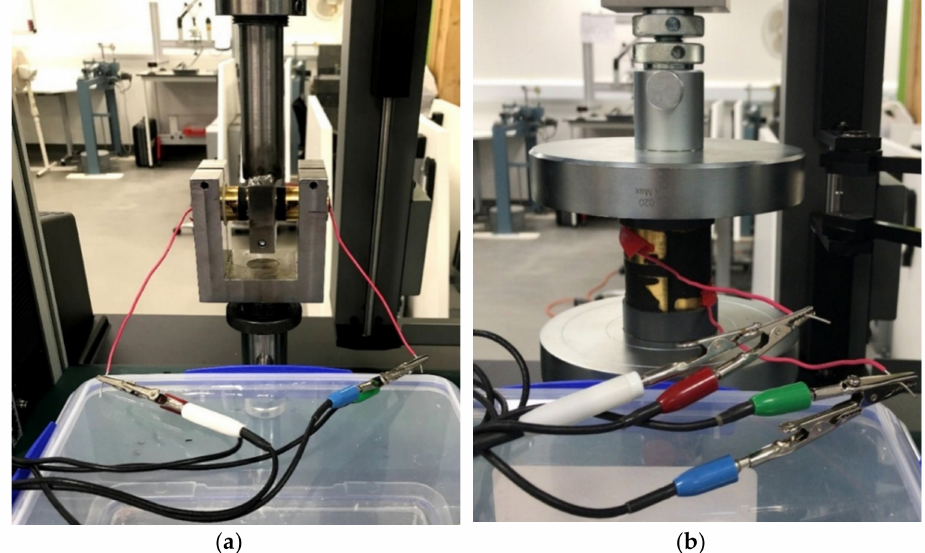
Figure 4. Resistance measurement, ( a ) DBS test equipment, ( b ) Compressive test equipment.